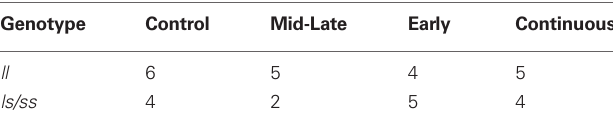
Table 1 | Sample size and genotype distribution as a function of prenatal treatment